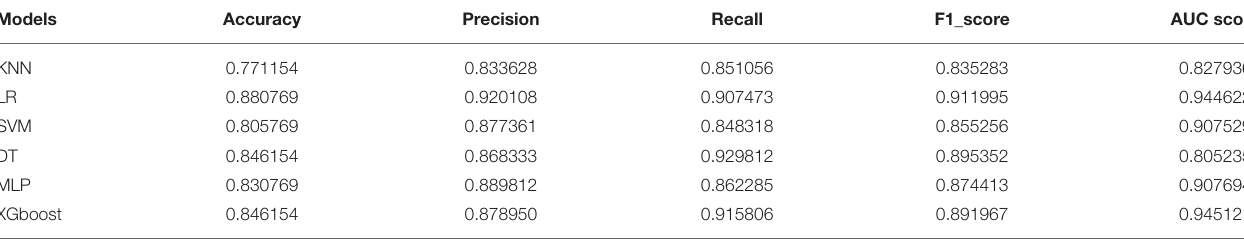
TABLE 3 | Performance summary of six machine learning models to predict CAD development.